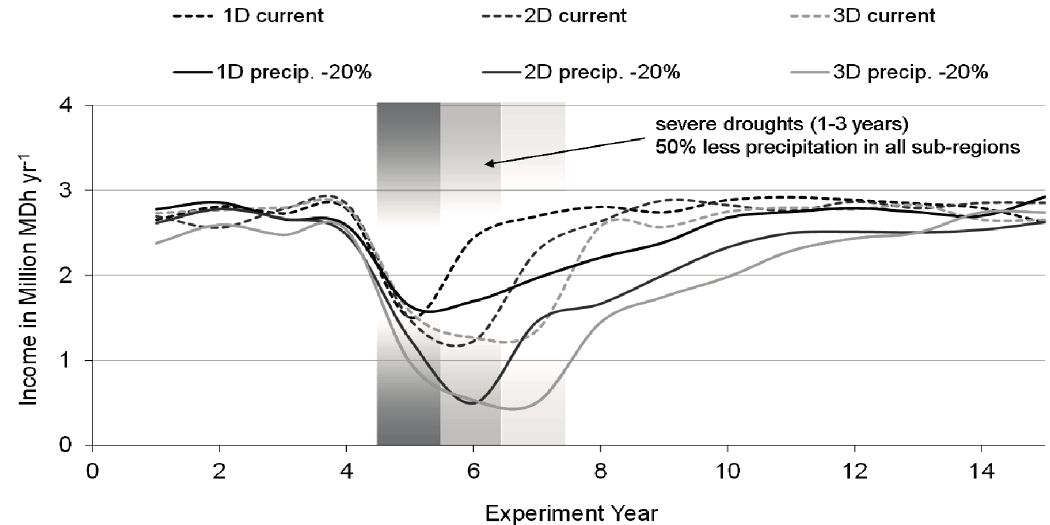
Figure 9. Ensemble means (N = 15) of total annual income from pastoralism in the study region (transhumant + sedentary). In the experiment with minus 20% precipitation (solid lines) the pasture area which is used by transhumant herds is additionally reduced to 55%. 1D, 2D, and 3D are scenarios with droughts of one to three years in length; income in million Moroccan